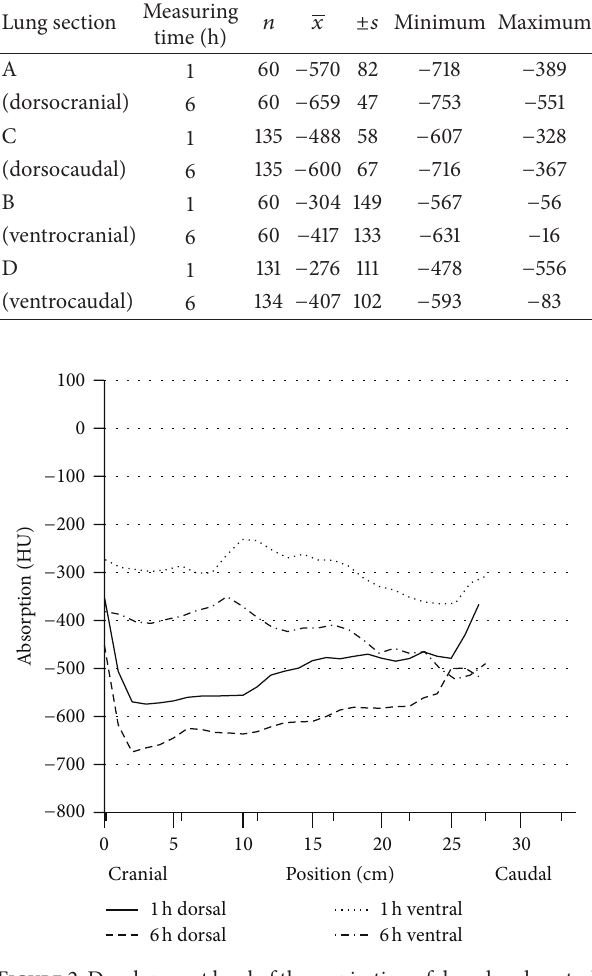
Figure 2: Development level of the respiration of dorsal and ventral lung parenchyma in HE of vital calves (group A 𝑛 = 15 ) during the first two measurement points at the first day of life, difference 𝑃 < 0.001 , numbers in 𝑥